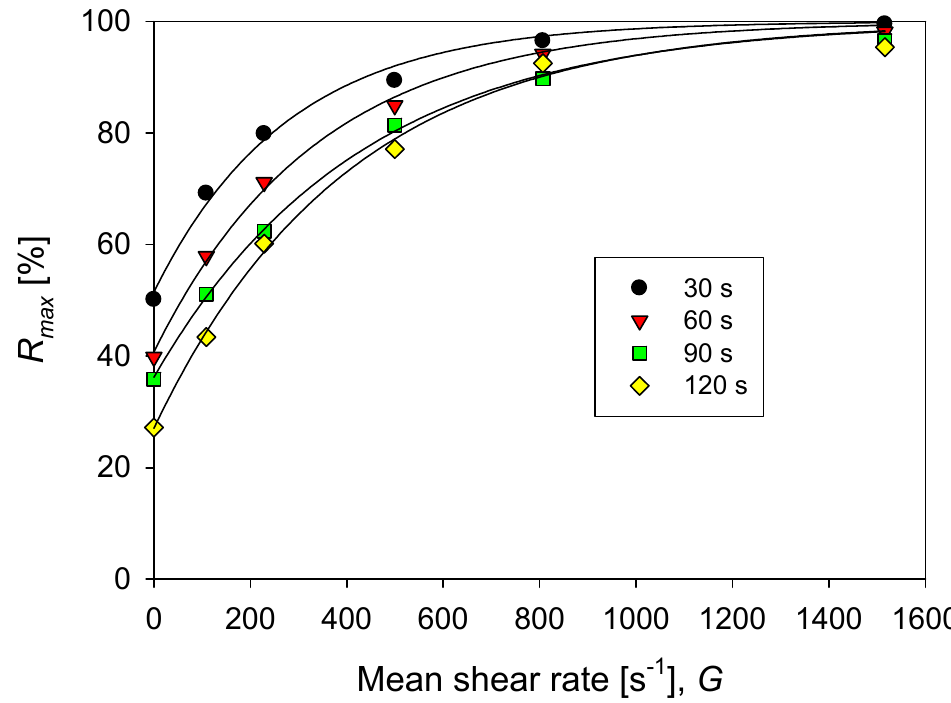
Figure 7. Percentage of maximum rupture (at an infinite time) of aggregates of kaolin in solutions with different doses of flocculant in SW and IW for each increase in agitation from the base of G = 273 s − 1 (200